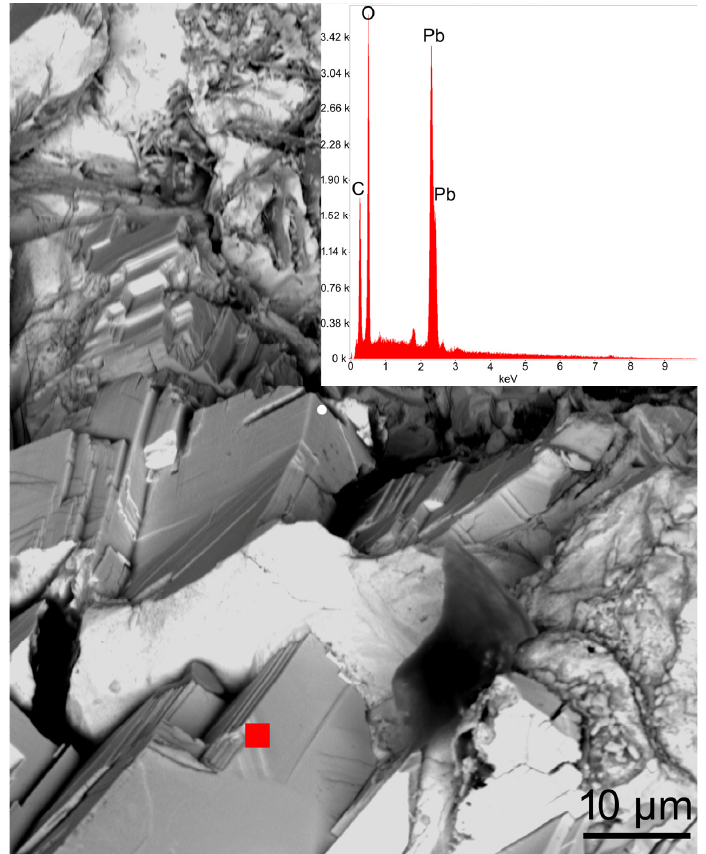
Figure 6. SEM image and corresponding EDS spot analysis (red filled square) of cerussite crystals from the Mastricarro Barite Mine (Catanzaro, southern Italy). The cleavage planes are clearly visible.